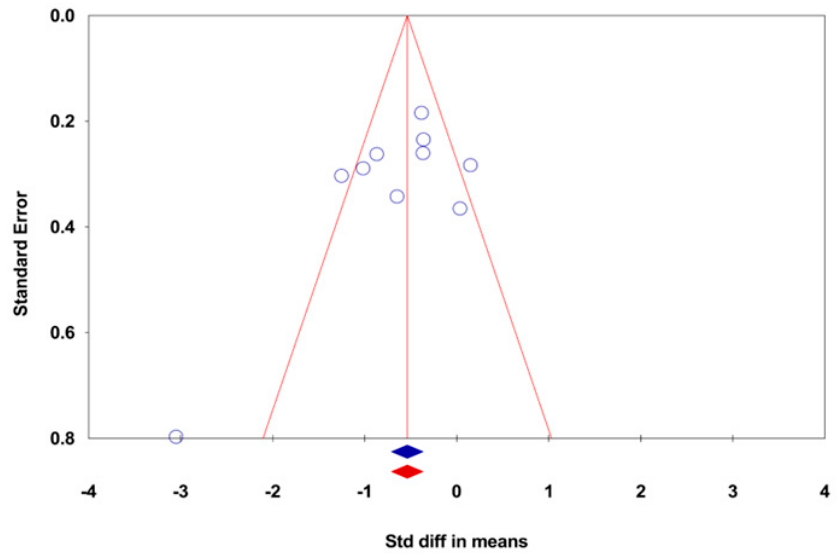
Figure 3. Funnel Plot Representing the Standard Error against the Standardized Difference in Means.